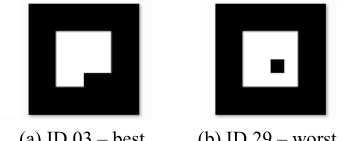
Fig. 6. The best (a) and the worst (b) recognized